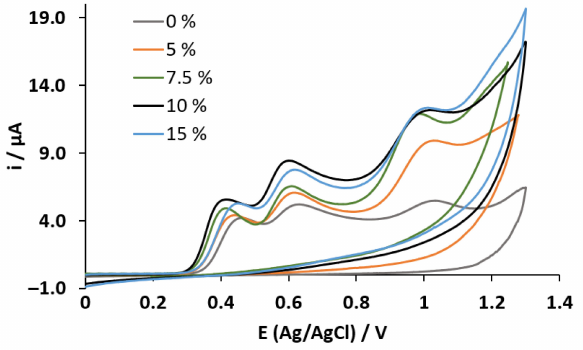
Figure 4. CVs obtained using different MWCNT percentages in the working electrode for a sample containing a mixture of paracetamol, diclofenac, naproxen, and aspirin.